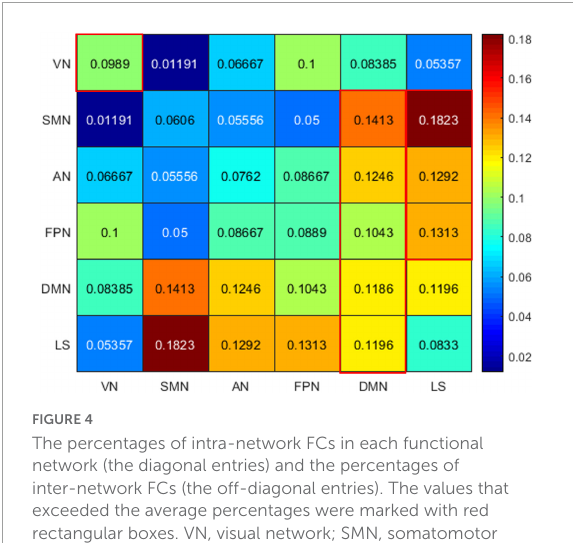
FIGURE4 The percentages of intra-network FCs in each functional network (the diagonal entries) and the percentages of inter-network FCs (the off-diagonal entries). The values that exceeded the average percentages were marked with red rectangular boxes. VN, visual network; SMN, somatomotor network; AN, attention network; FPN, frontoparietal network; DMN, default mode network; LS, limbic